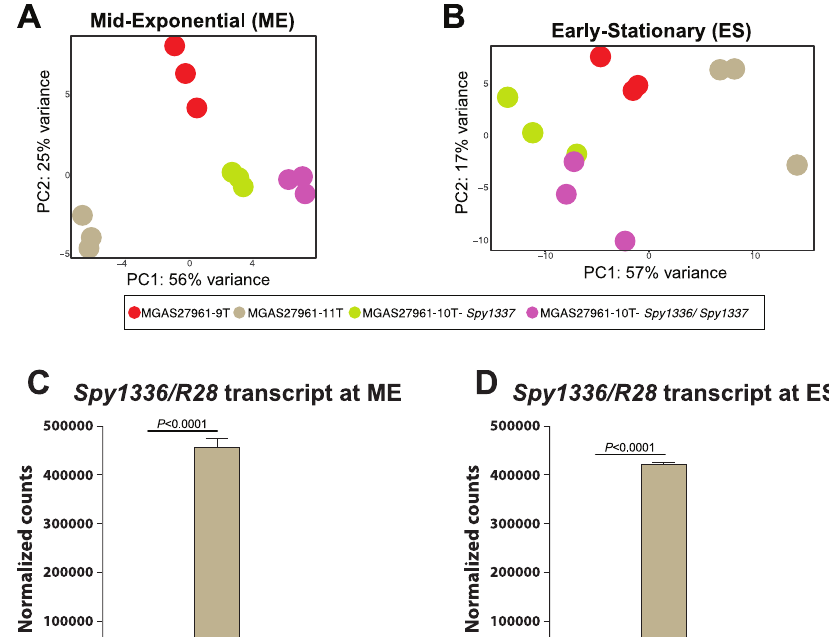
PLOS ONE | https://doi.org/10.1371/journal.pone.0229064 March 26,